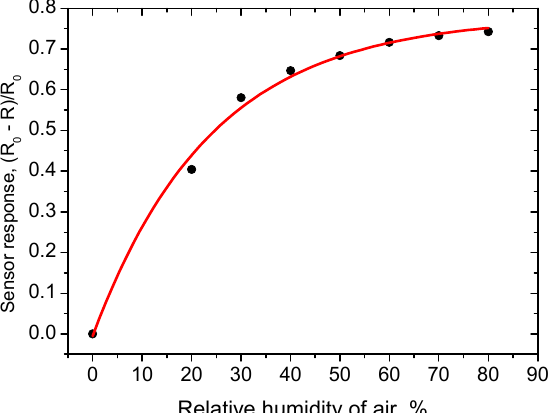
Figure 10. Sensor response as a function of hydrogen concentration in a range up to 500 ppm at relative humidity of 60%. σ 0 is the sensing layer conductivity at zero hydrogen concenetration, σ is the conductivity in gas mixture H 2 /air .